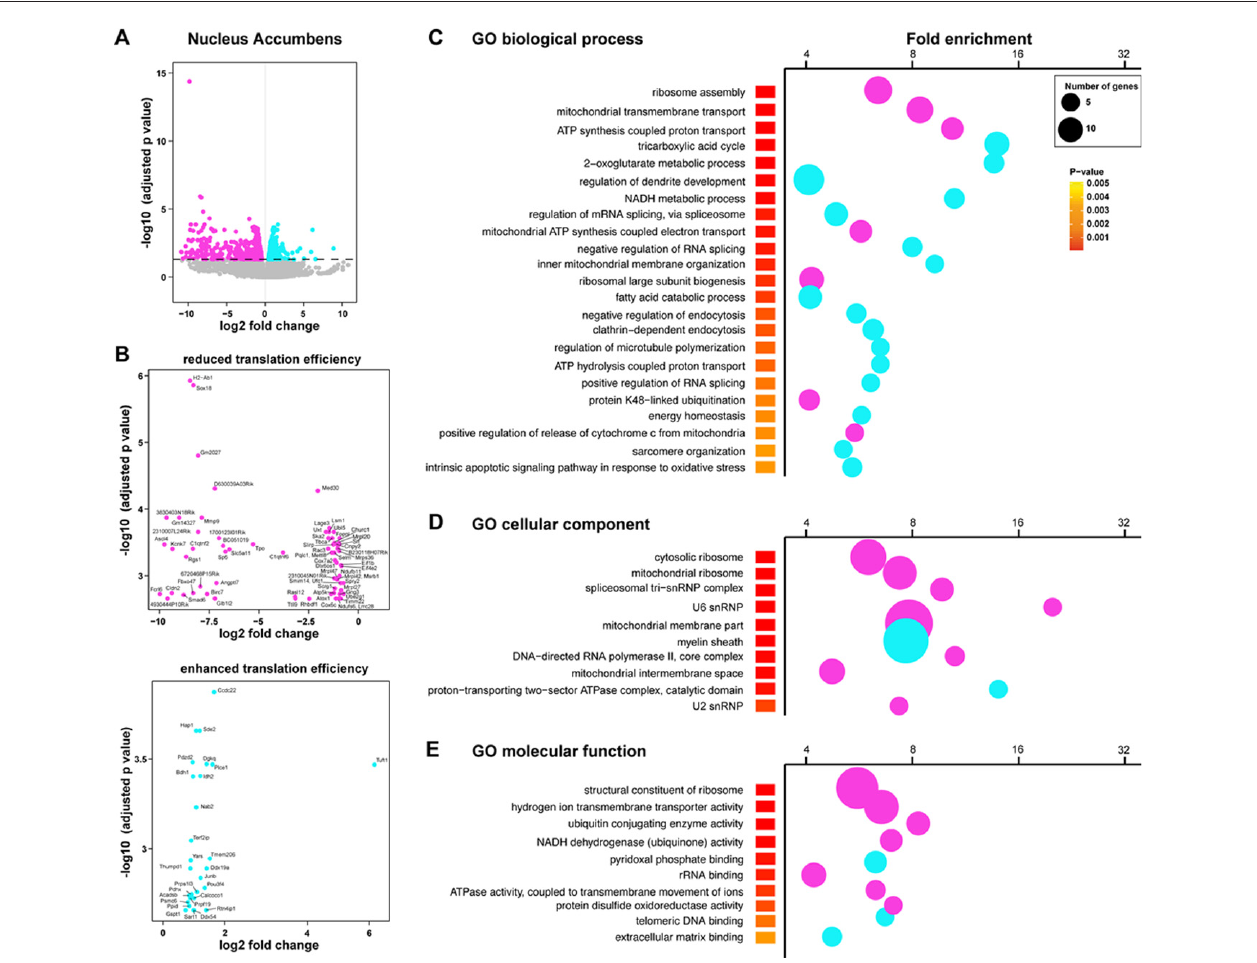
FIGURE 6 | Altered translational efficiency of a subset of mRNAs in the Acb of rpS6 P − / − mice. (A) Volcano plot obtained from Xtail analysis of translational efficiency in the Acb. Log2 of the translational fold change is shown on the horizontal axis, and − log10 of the P value is shown on the vertical axis. Genes with significant increase or decrease in translational efficiency are represented in cyan or magenta, respectively. (B) Volcano plot obtained from Xtail analysis of genes with decreased (top) or increased (bottom) translational efficiency in the Acb of rpS6 P − / − mice (C–E) Enriched terms of GO analyses including biological process (C) , cellular component (D) , and molecular function (E) of mRNAs whose translational efficiency is significantly changed in the Acb between wt and rpS6 P − / − . The fold-enrichment (cutoff > 4) is displayed for each GO terms using Fisher’s exact test (see “Materials and Methods” section). The size of the dots is proportional to the number of genes associated with a given GO